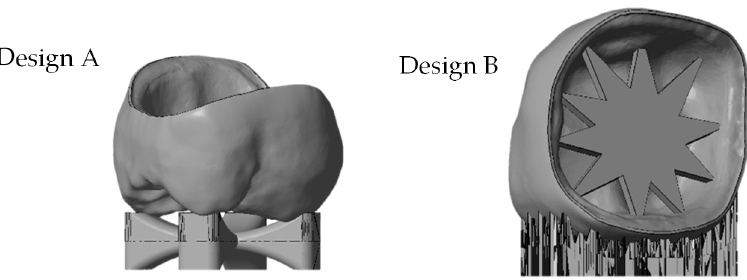
Figure 2. stl file of the molar crown with different support designs (from left: ‘cross’-support Design A, ‘star’-support Design B).